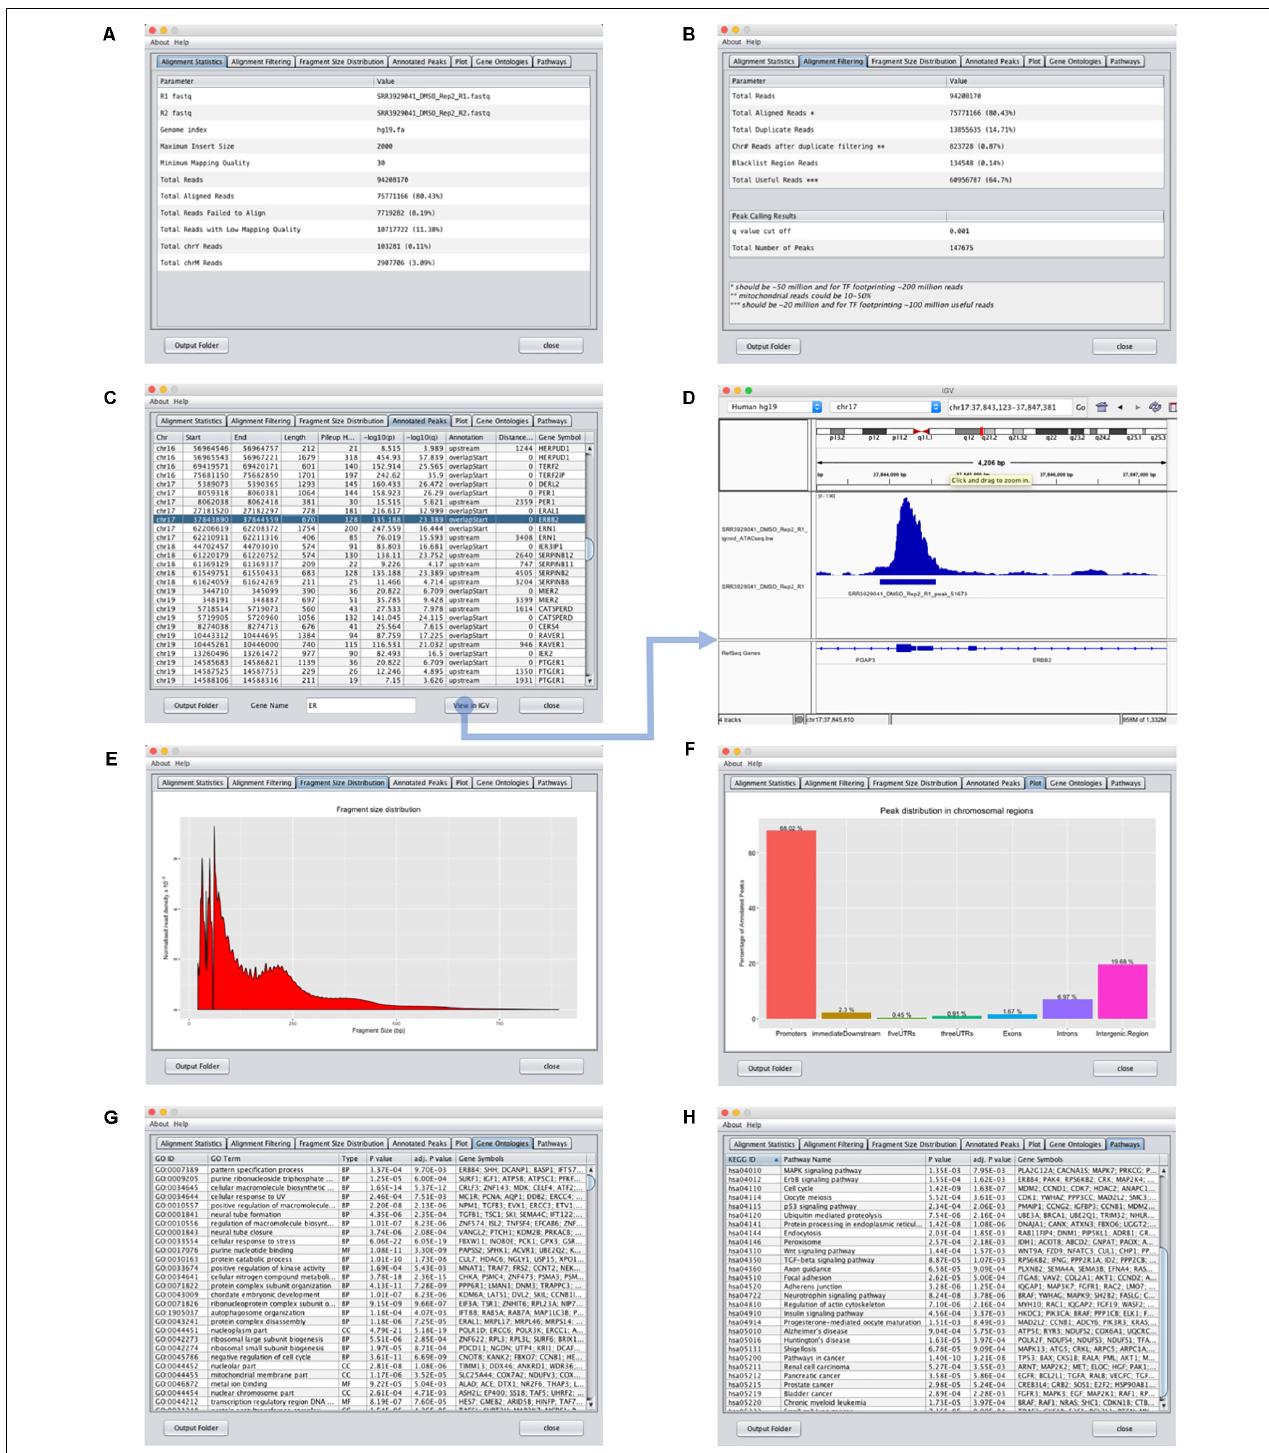
FIGURE 3 | Output interface for GUAVA ATAC-seq data analysis. (A) Input summary and alignment statistics. (B) Read filtering and peak calling summary. (C) Peak annotation table with sorting and filtering functionality. Easy access to IGV for visualizing peaks and automatically generated normalized ATAC-seq signal by GUAVA. (D) Visualization of ATAC-seq peaks with IGV. (E) Graph showing the fragment size distribution. (F) Bar chart showing the percentage of peaks in various genomic locations such as the promoter, intron, exon, and UTR, etc. (G) Plot showing the percentage of the peaks upstream and downstream of the TSS of the nearest genes. Different colors indicate different ranges of distances from the TSS. (H) Over-represented KEGG pathways obtained using the ChIPpeakAnno bioconductor package.